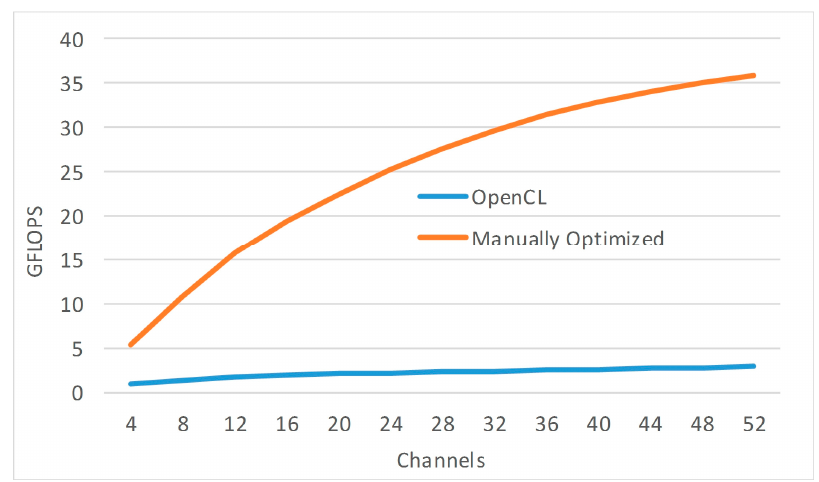
Figure 16. Comparing OpenCL performance to manually optimized code (8192 range gates) for beamforming.